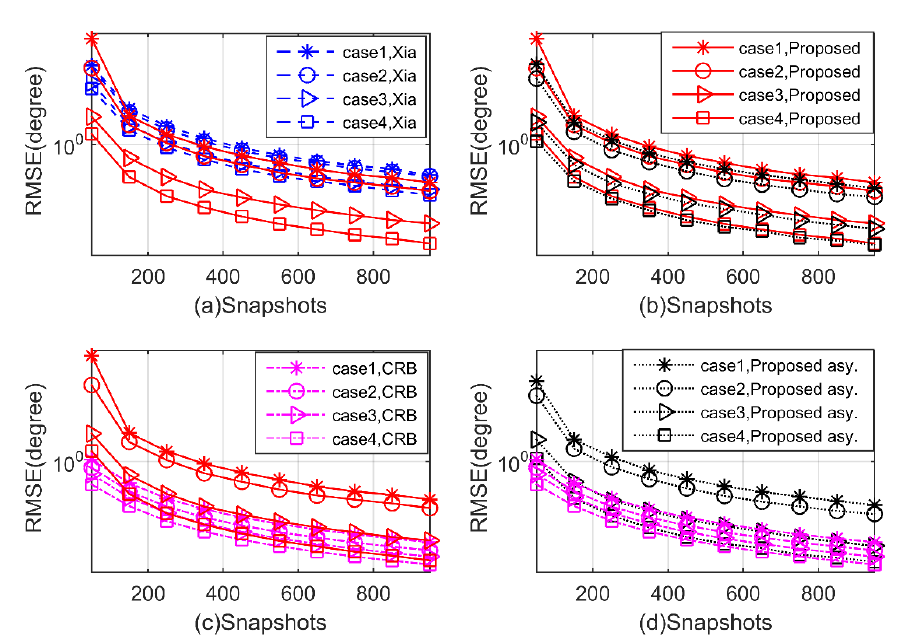
Figure 9. RMSE of 2D-DOA for mixed signals versus snapshots ( a–d